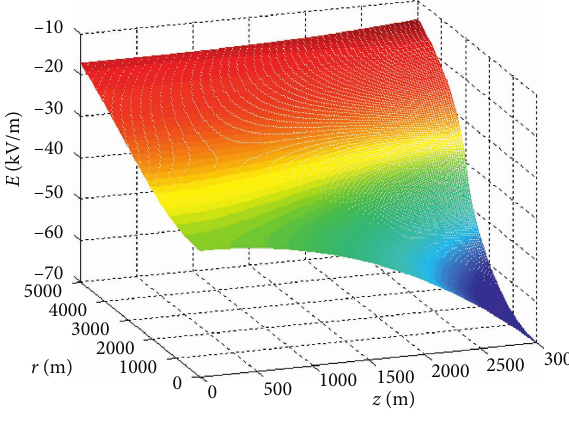
Figure 2: Accurate solution.